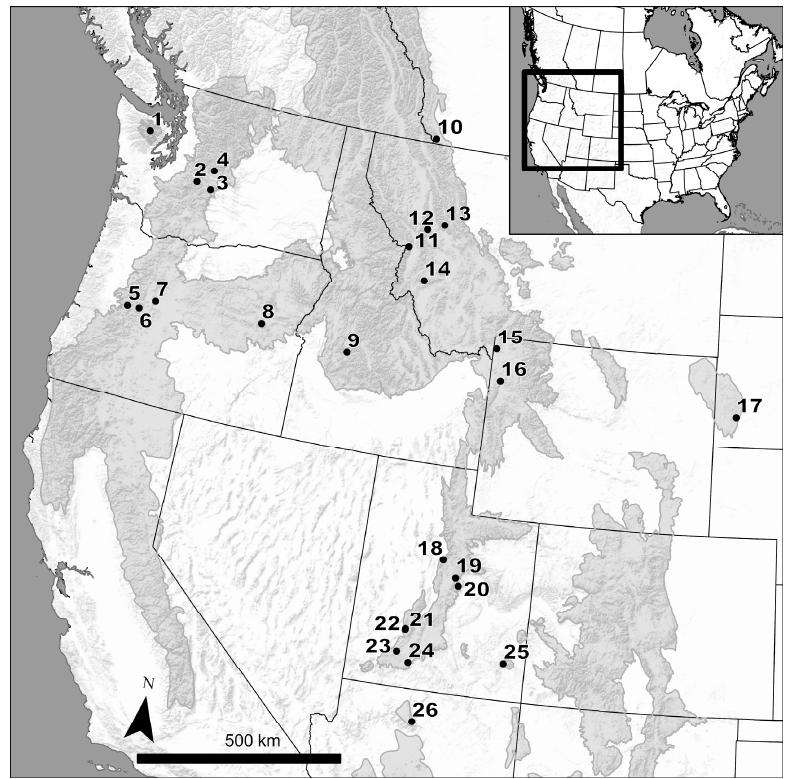
Figure 1. Location of the 26 fires in the western portion of North America (inset map). Montane-forested ecoregions are displayed in light gray (EPA Level II Ecoregions Northwestern Forested Mountains and Temperate Sierras [54]). Numbers correspond to individual fire IDs (see Table 1).